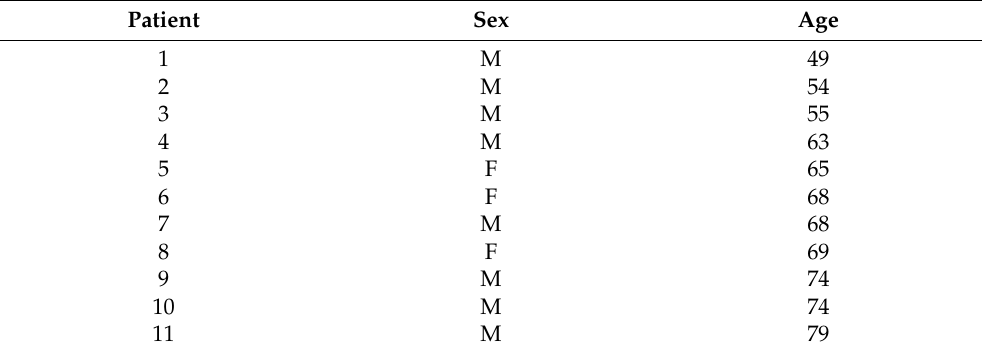
Table 1. Demographic data of the patients included in the study in ascending order of